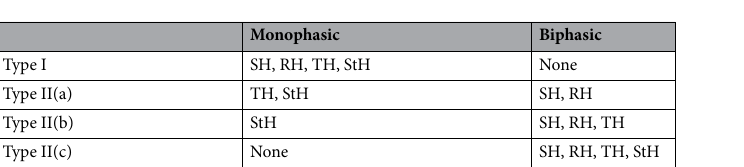
Table 1. The classification the muscle activation patterns observed in oropharyngeal muscles during swallowing test. SH, suprahyoid muscle; RH, retrohyoid muscle; TH, thyrohyoid muscle; StH, sternothyroid muscle.